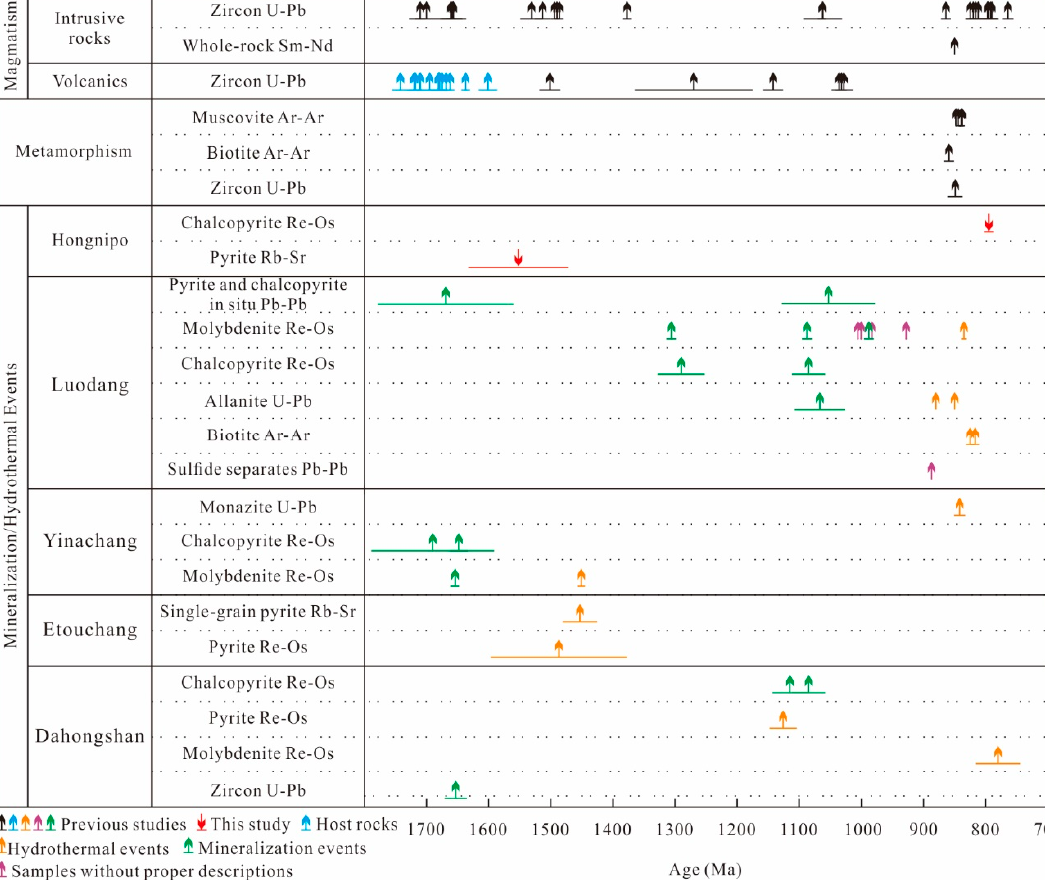
Figure 10. Summary of geochronological data, showing the timing of magmatism, metamorphism, hydrothermal events, and mineralization for the Kangdian copper belt. Data sources as referenced in text and includes the data of present study.